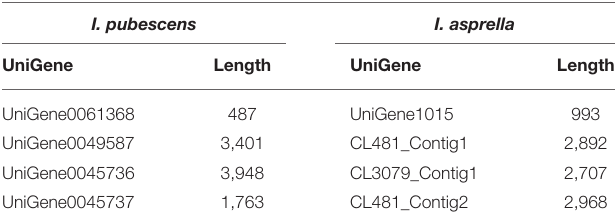
TABLE 4 | Orthologs of OSC s in I. pubescens and I. asprella